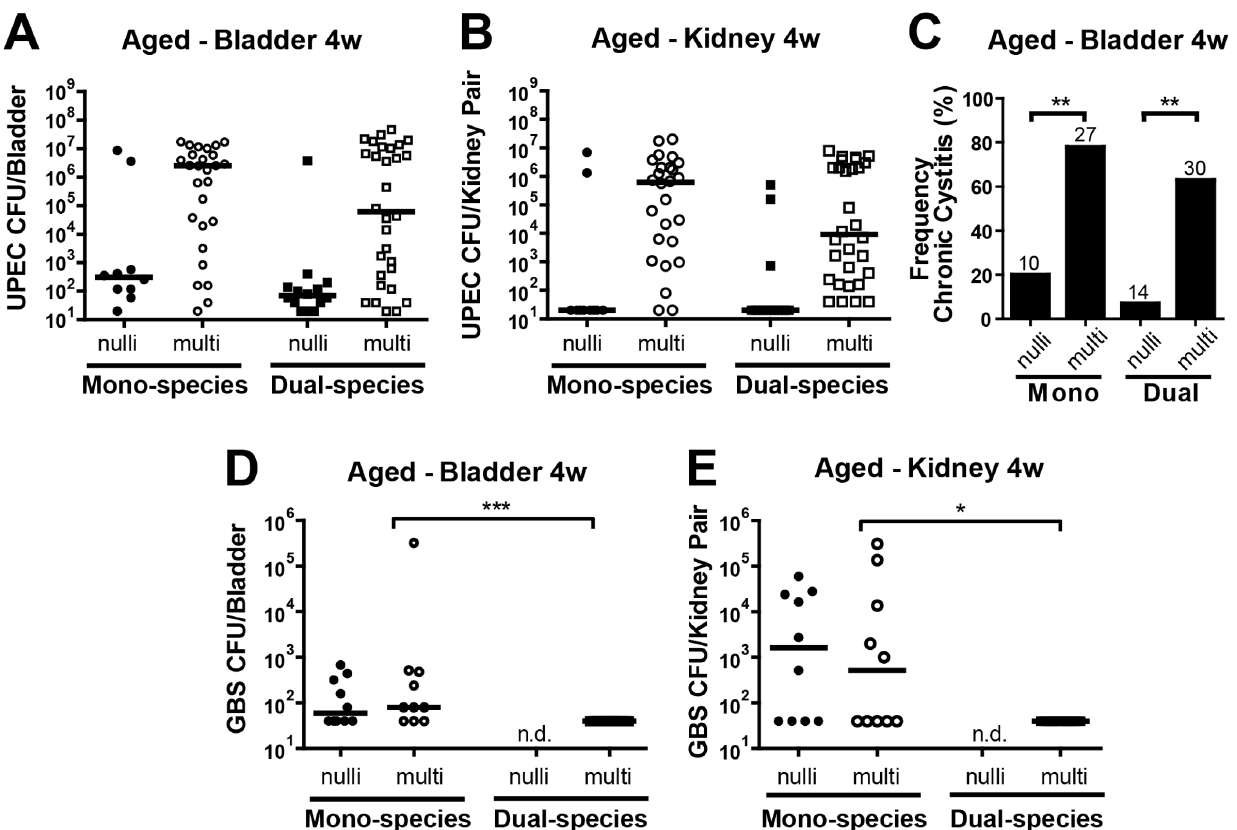
Figure 4. Multiparity is associated with more severe chronic UPEC UTI. Bacterial CFU in the bladder ( A,D ) or kidney ( B,E ) at 4 weeks post infection following infection of C3H/HeN 7–11 month female mice with , 10 7 UPEC alone, GBS alone, or , 10 7 of each organism simultaneously. For CFU analysis, N=3–8, at least 5 mice per experiment. The horizontal bar represents the median value for each group of mice. Statistical significance was determined by the Kruskal-Wallis test with Dunn’s post-test for multiple comparisons. * P , 0.05, ** P , 0.005, *** P , 0.0005. N.d. indicates groups in which no data were collected. ( C ) The percentage of mice displaying . 10 4 CFU/bladder at 4 wpi, indicative of chronic cystitis. The number of mice (n) for each infection group is indicated above the bar. Fisher’s Exact test was used for statistical